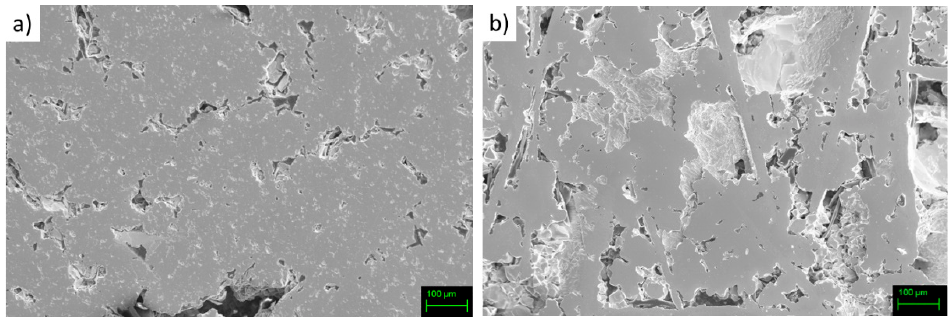
Figure 1. SE-SEM microphotographs of the polished surface of bulk samples ( a ) Fe63 and ( b ) Fe70. Backscattered (BS) images and EDS analyses suggest that the main phase is the desired skutterudite, with composition Sm 0.17 (Fe 0.60 Ni 0.40 ) 3.75 Sb 12 and Sm 0.38 (Fe 0.69 Ni 0.21 ) 3.75 Sb 12 for samples Fe63 and Fe70, respectively. Nevertheless, the presence of the additional phase SmSb 2 , which is commonly found in non-perfectly monophasic samples belonging to this system [45], can be observed too, as can be inferred from Figure 2.